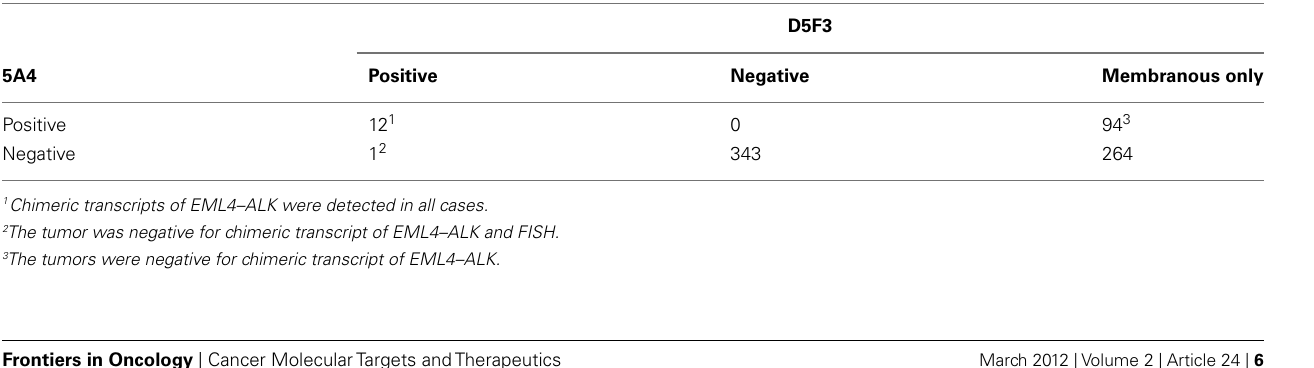
Table 5 | Comparison of IHC results according to the difference of antibody clones (5A4 and